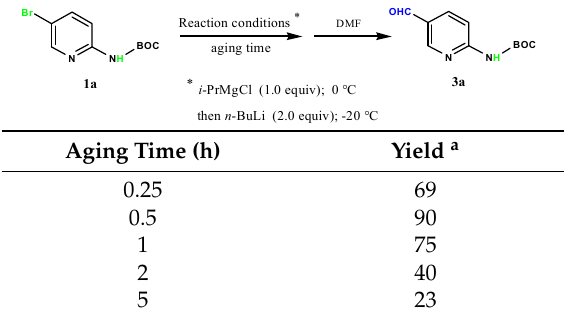
Table 2. Stability of metalating reagents prepared from 2-( N -BOC-amino)-5-bromopyridine.